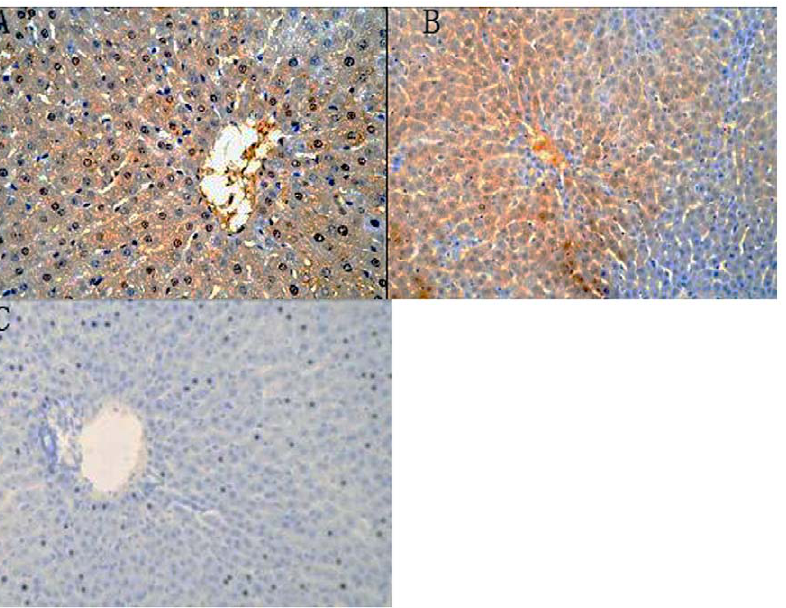
Figure 5. Immunohistochemical staining of HEV proteins in the liver. A: Strong positive signals in the cytoplasm (40 6 ). B: Sheets of liver cells were positive for HEV proteins (20 6 ). C: No positive signal (control group; 20 6